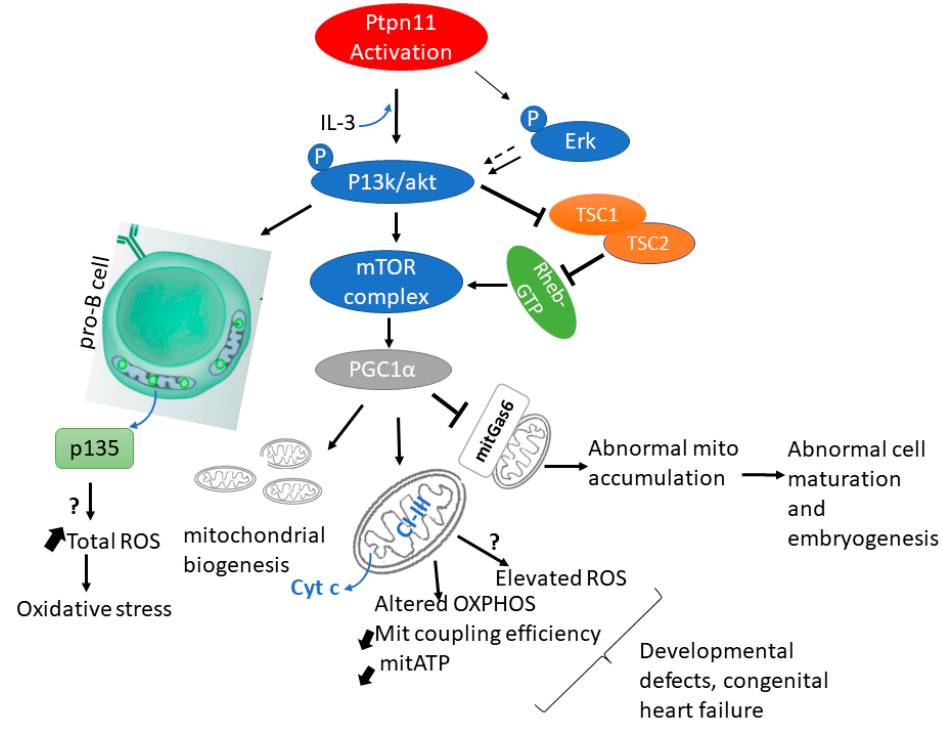
Figure 1. Activating Ptpn11 mutation through Erk/PI3k/Akt/mTOR signalling affects mitochon- drial function. The presence of IL-3 (upward-blue arrow), active ptpn11 activates p13k/Akt signalling which inturn triggers the release of a mitochondria protein, p135 through an unknown mechanism(?). p135 release causes an increase (up-slanted arrows) in total ROS responsible for oxidative stress in tissues. Activated PI3K/Akt activates mTOR. Hypeactivated mTOR blocks the mitochondrial Growth arrest protein (mitGas6) leading to abnormal cell maturation. Via hyperactivated mTOR, Ptpn11 alters mitochondria respiration by decreasing (down-slanted arrows) CI-III of the ETC and coupling efficiency, releasing cyt c to the cytoplasm and reducing mitochondrial ATP.